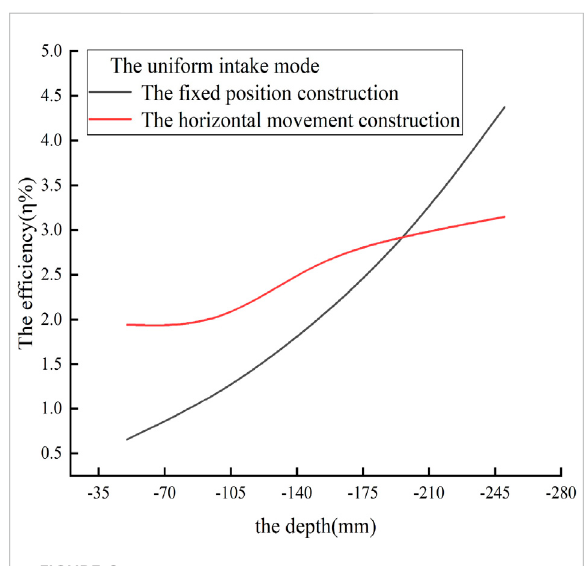
FIGURE 6 Variation of the air-lifting pump ef fi ciency with sand